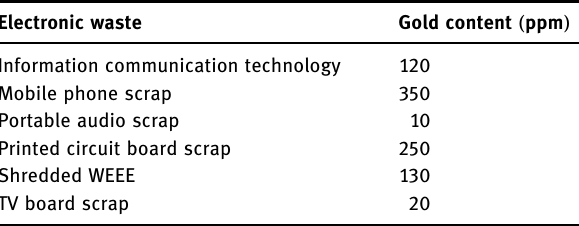
Table 3: Gold content in various types of electronic wastes Electronic waste Gold content ( ppm